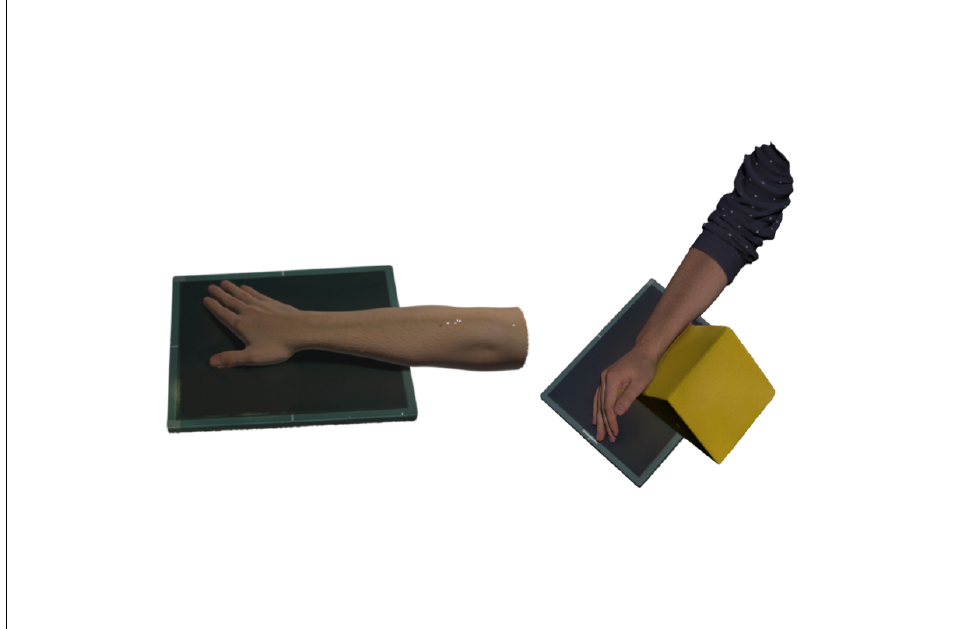
Figure 5. Three-dimensionally scanned arm in position for two radiographs of the scaphoid